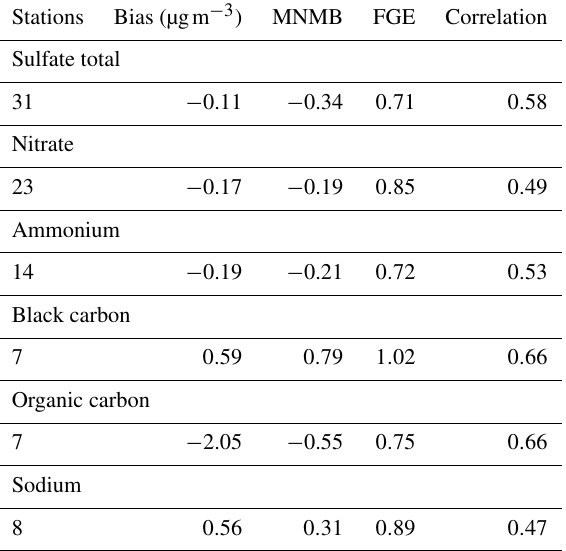
Table 8. Statistics of the comparison between the MOCAGE simu- lation and the EMEP measurement database for the year